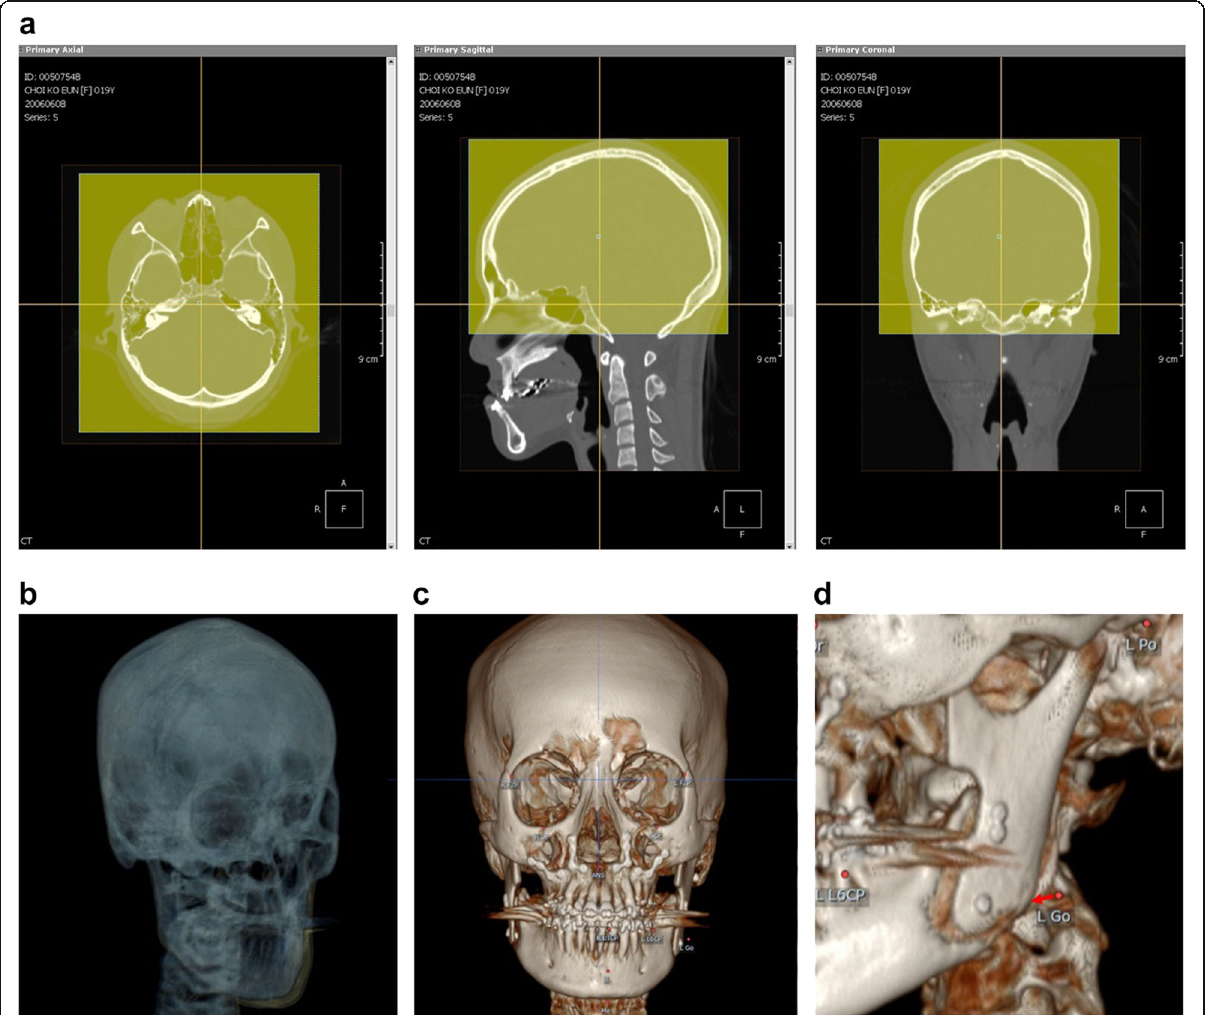
Fig. 4 In three-dimensional simulation software, serial 3D-CT data were superimposed automatically on the best fit of cranial base structures by using volume registration ( a , b ). Three-dimensional positions of landmarks which were selected on preoperative CT images were saved and loaded on postoperative CT images ( c ). If the positions of measurement landmarks were changed after surgery, it can be moved to the new position on the software and the new coordinate data can be saved without the positional change of reference landmarks ( d